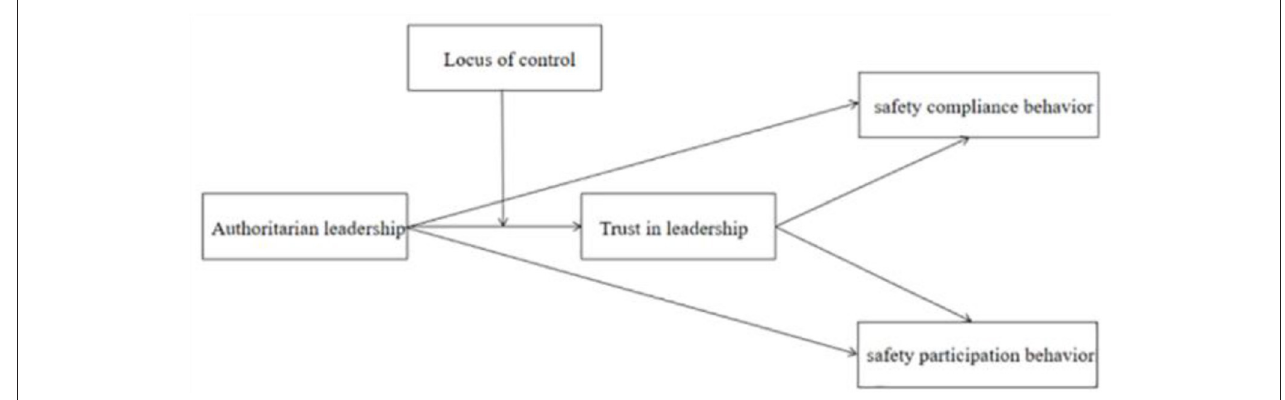
FIGURE 1 | The hypothesized